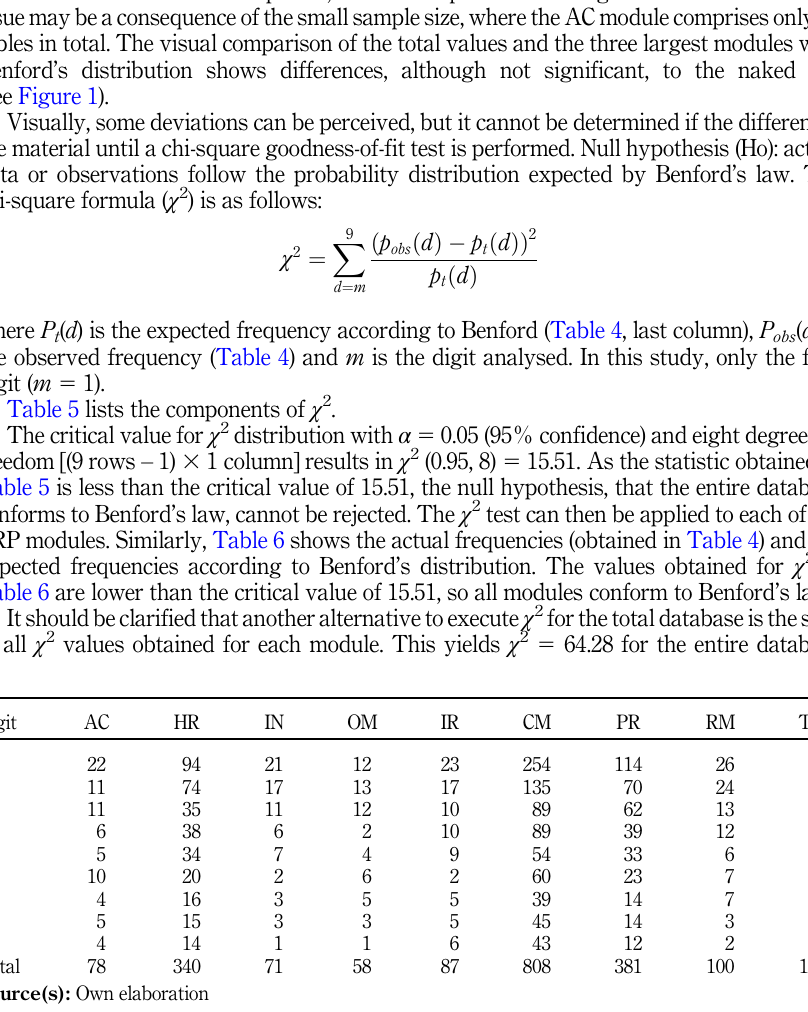
occurrence of first digit in the tables of each ERP